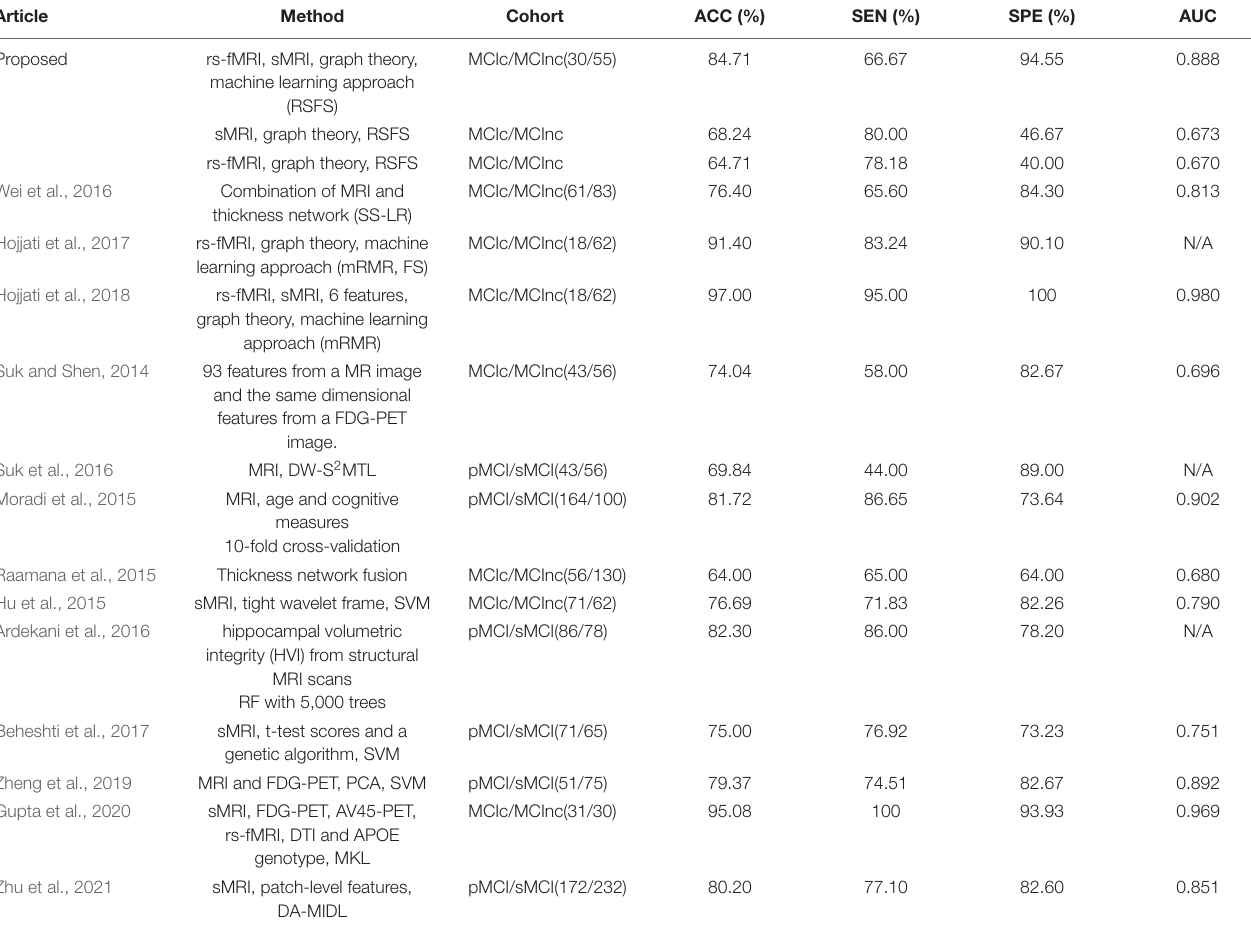
TABLE 8 | Classification performance of different methods to distinguish different stages of